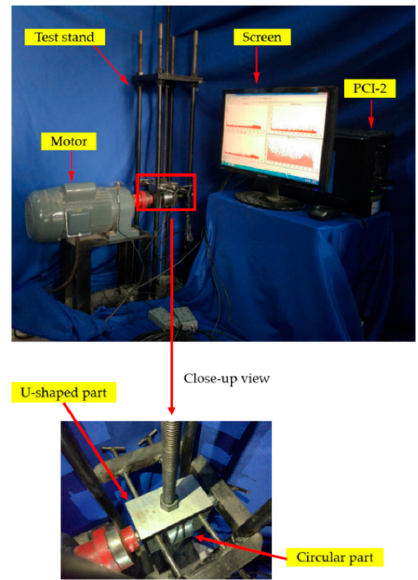
Figure 3. Photos of the experimental apparatus.